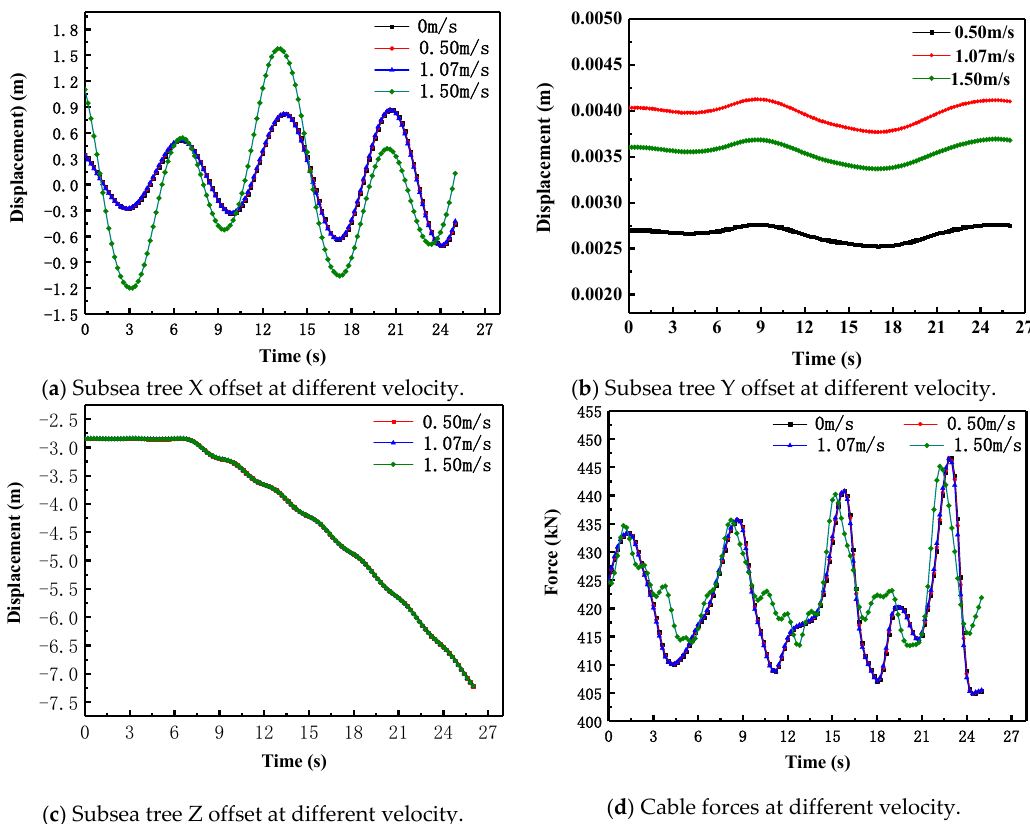
( d ) Cable forces at different velocity. Figure 6. Subsea Tree offset and cable forces at different velocity.